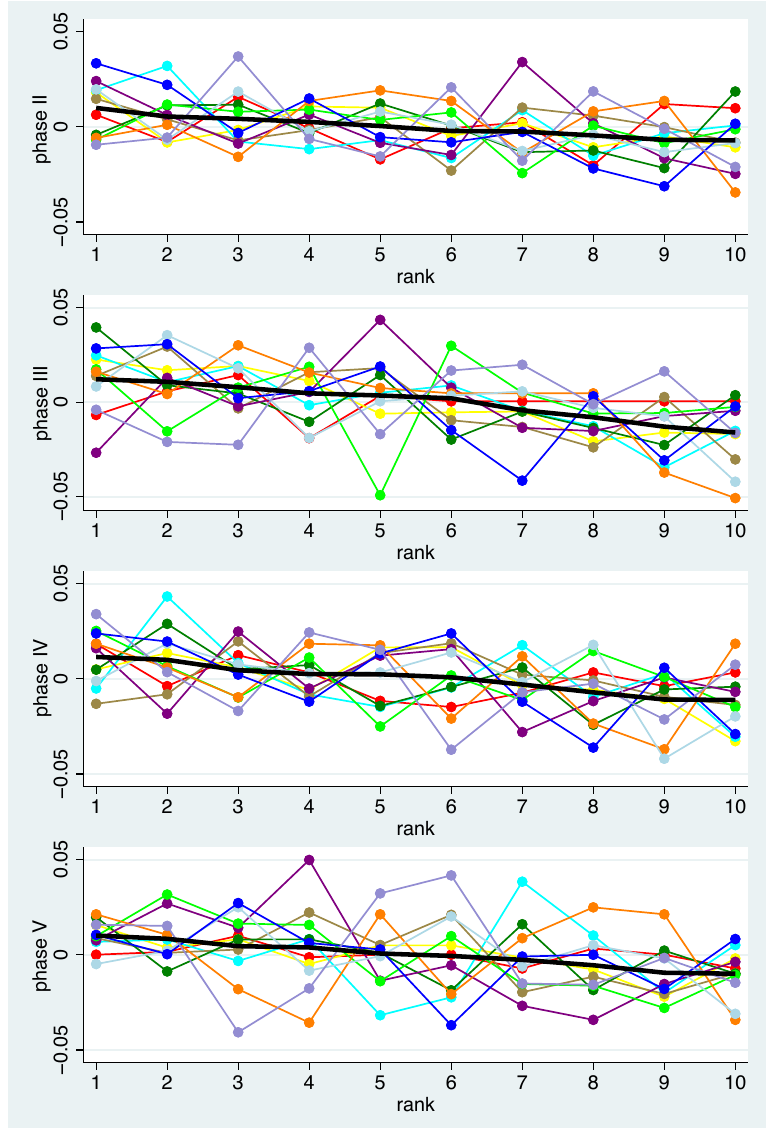
Figure 3. Individual mean changes for all bacteria and phases. Black line: population mean. The bacteria in each phase are in descending order according to their mean